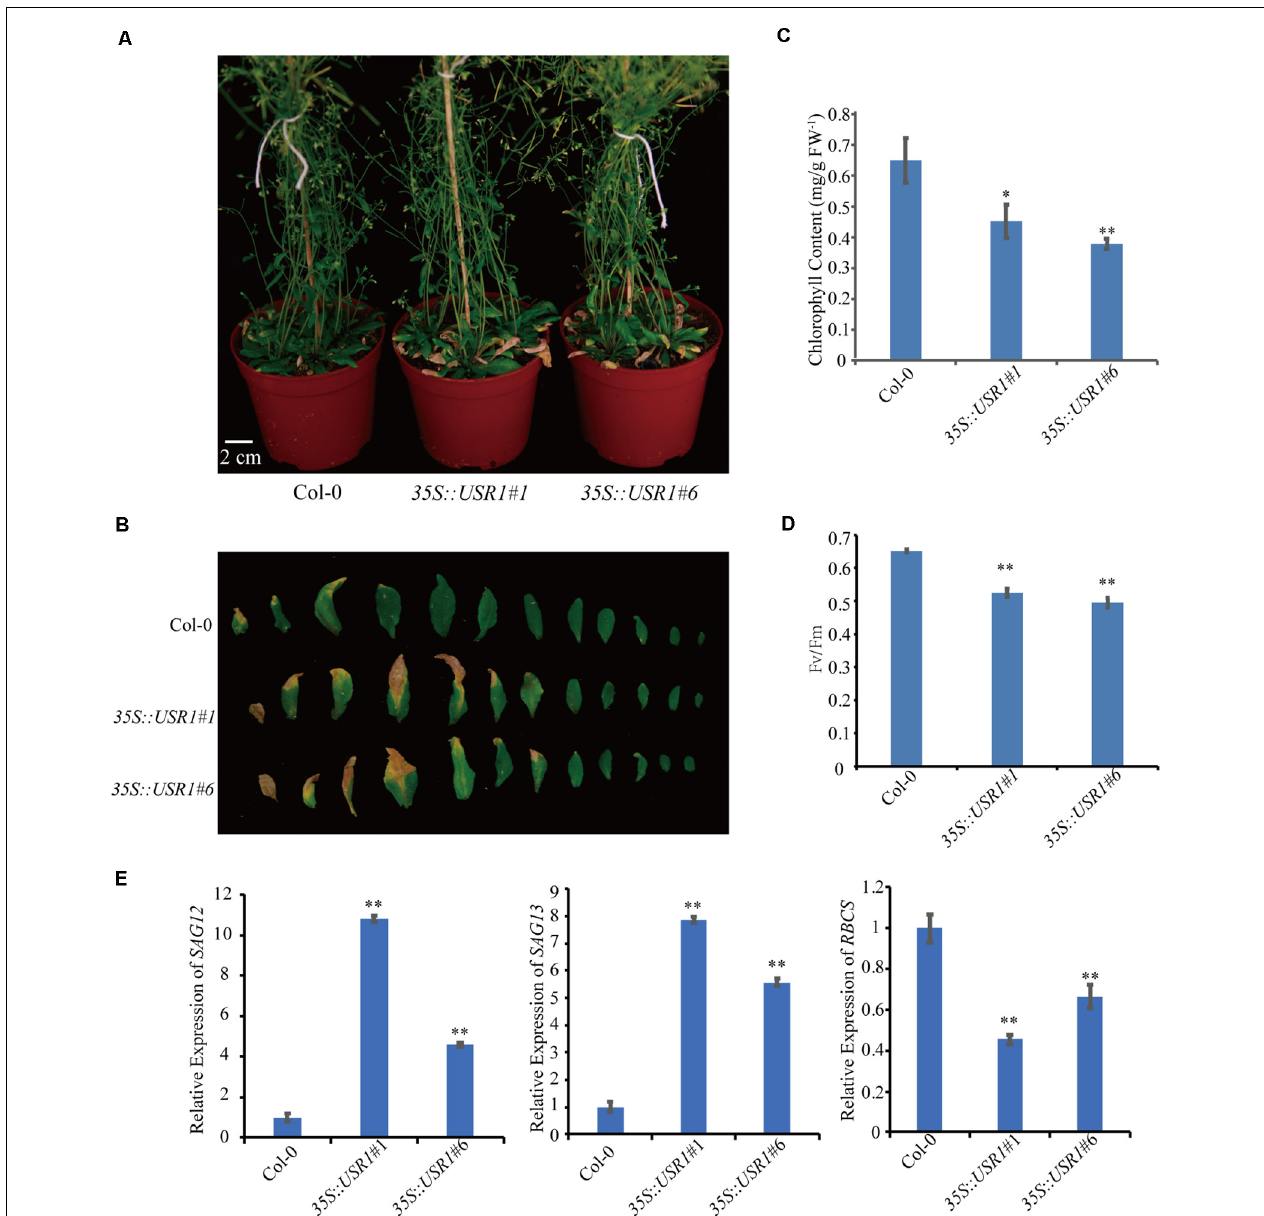
FIGURE 3 | AtUSR1 overexpression accelerates leaf senescence. (A) The precocious senescence phenotype of AtUSR1 overexpression lines after grown under continuously light condition for 40 days. (B) The phenotype of 1st–12th leaves detached from plants with different genotypes. (C,D) Chlorophyll content and Fv/Fm detection at different leaf positions in Col-0, two independent AtUSR1 overexpression plants as indicated. (E) Expression pattern of SAG12 , SAG13 , and RBCS in plants overexpressing AtUSR1 and in Col-0. Single and double asterisk indicate significant difference at 0.01 < P < 0.05 and P < 0.01 levels using student’s t -test. Data are shown as the mean ± SD from three independent